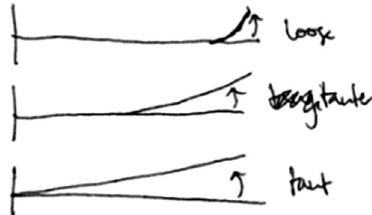
FIG. 11. Student drawing accompanying the response “ [A] tauter string means a greater length is affected at once by the movement (longer λ ).